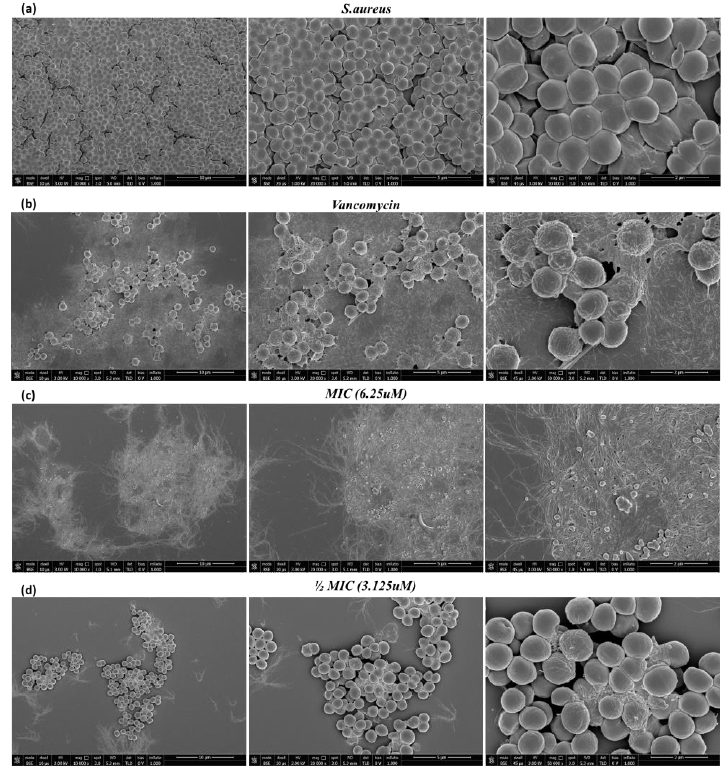
Figure 8. SEM analyses of S. aureus cells treated with Hylin-a1. ( a ) Untreated bacteria; ( b ) bacteria treated with vancomycin (6.9 μ M) as a positive control; ( c ): bacteria treated with MIC of Hylin-a1 (6.25 μM); ( d ): bacteria treated with ½MIC of Hylin-a1 (3.125 μM). The images were obtained at 10,000×, 20,000×, and 50,000× magnification.